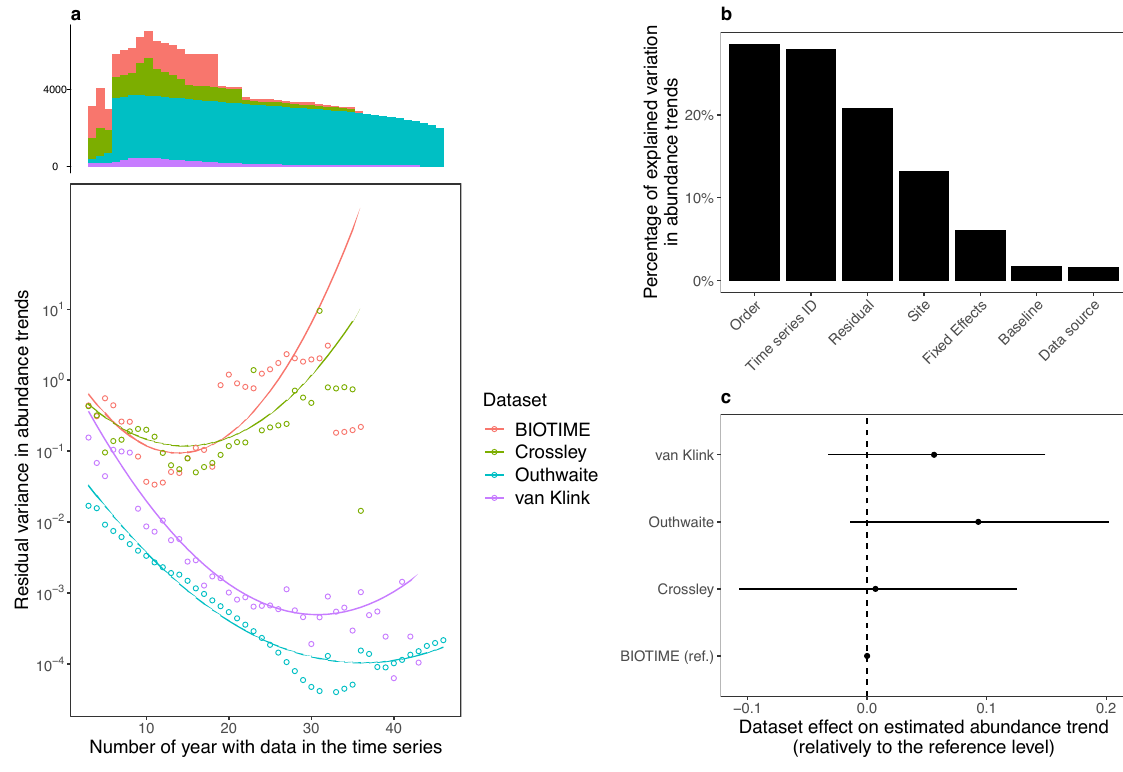
Figure 6: Variation in abundance trends is strongly structured by methodological effects. (a) Predicted (lines) and observed (points) residual variance of the model for each source dataset. Predictions are from equation (3). The histogram at the top shows the distribution of truncated time series along the x-axis, per dataset. (b) Variation in abundance trends explained by the model effects, and residual variation. (c) Black dots show the effect (± CI 95% ) of the source dataset on abundance trends, relatively to the reference level